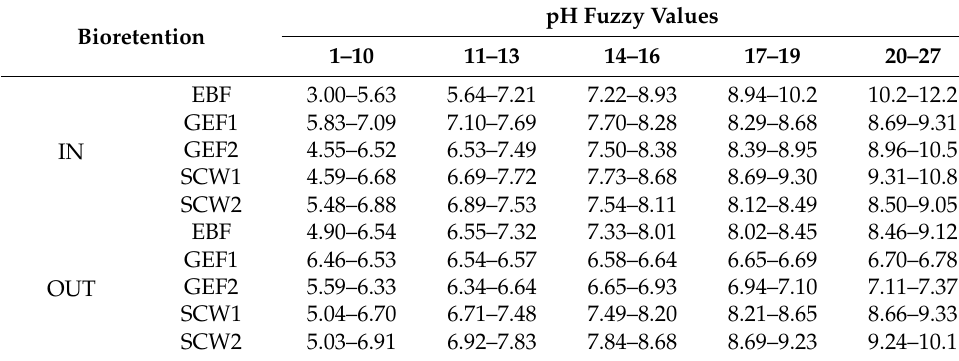
Table 3. Groupings of pH and its corresponding fuzzy